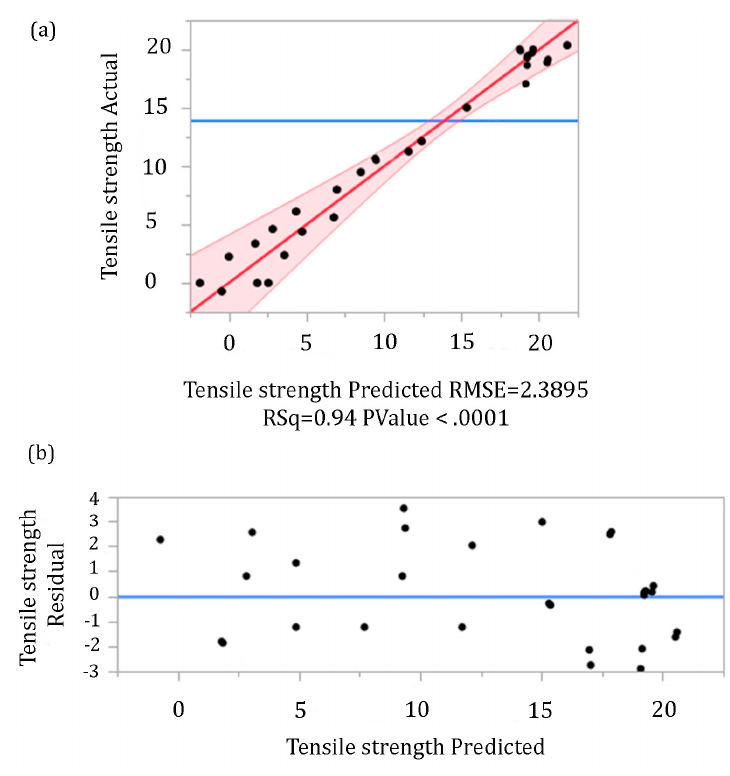
Figure 5. Diagnostic plots, ( a ) actual vs. predicted values of tensile strength; ( b ) deviation diagram of standardized residuals in relation to the zero line.